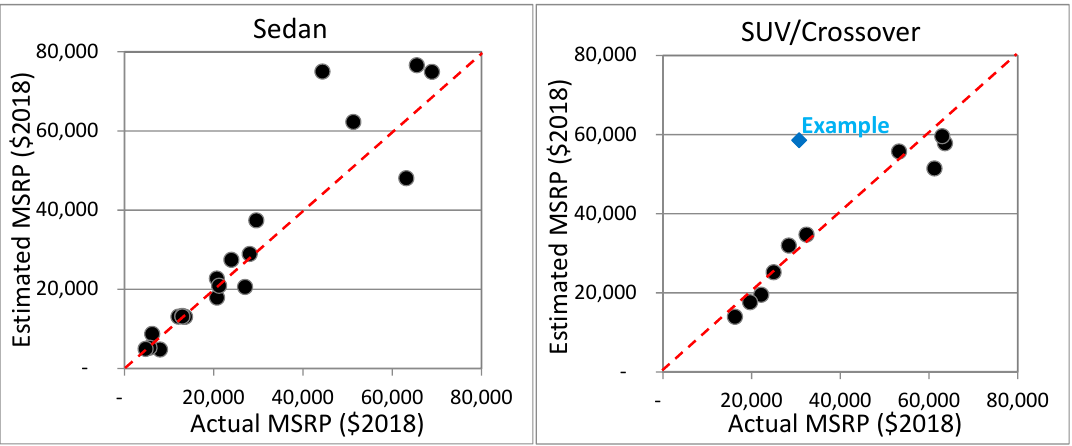
Figure 12. The out-of-sample estimates for selected vehicle models in the 2019 Chinese vehicle market.